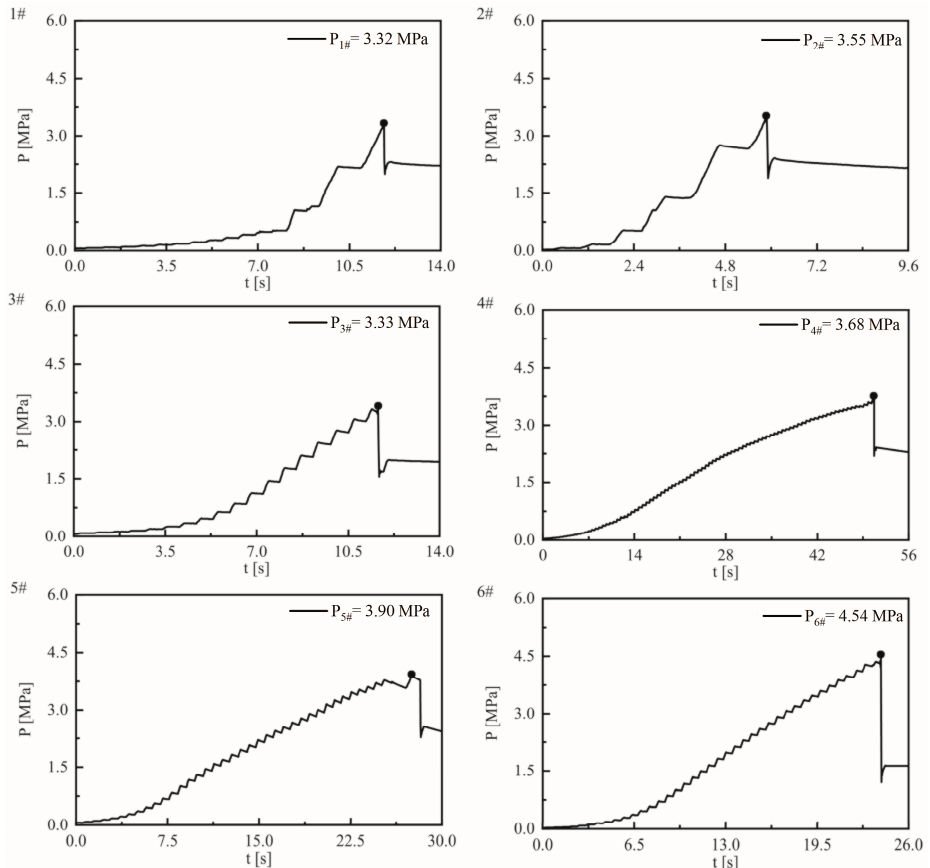
Figure 9. Pressure histories of one bi-segment cylindrical preform (preform 1) and five bi-segment bulged hulls (hulls 2–6) during hydrostatic tests.